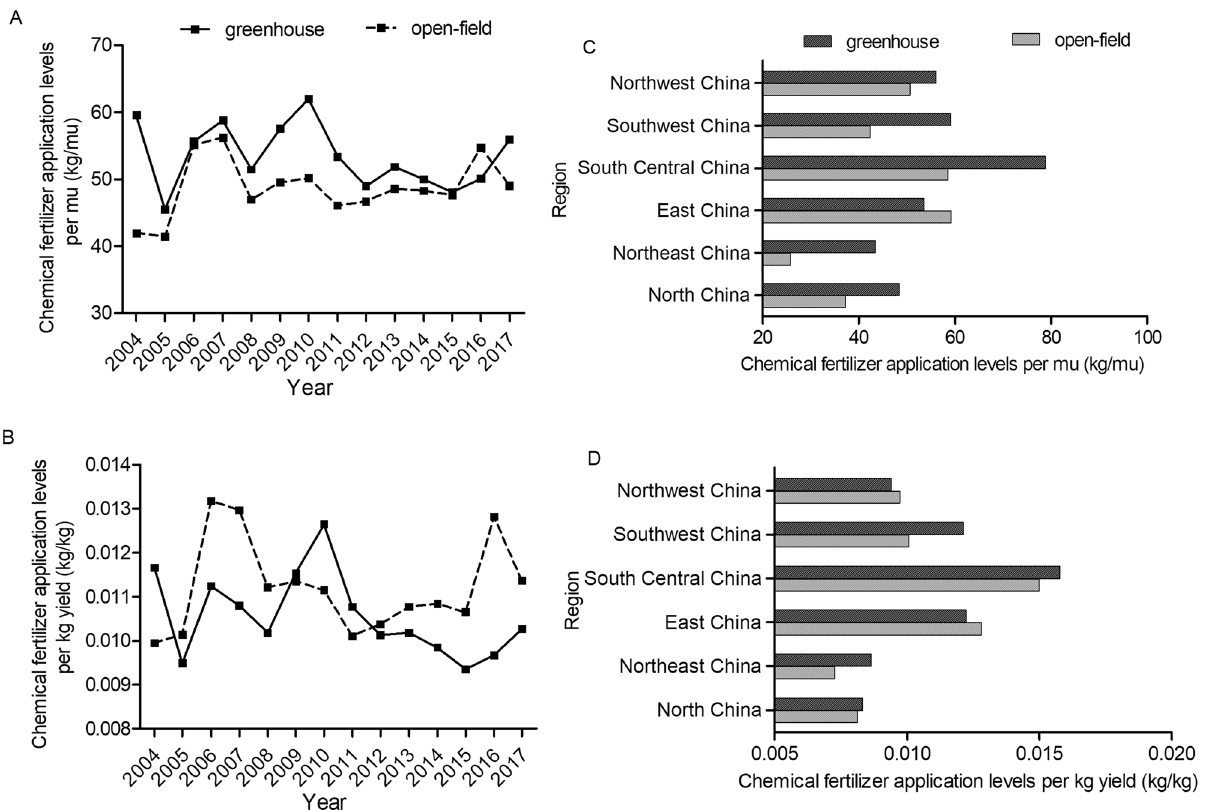
Figure 2. Chemical fertilizer application levels on greenhouse and open-field tomatoes. ( A ) and ( B ) presented chemical fertilizer application levels per mu and per kg yield during 2004–2017, respectively. ( C ) and ( D ) presented the average values of chemical fertilizer application levels (per mu and per kg yield, respectively) across six regions in